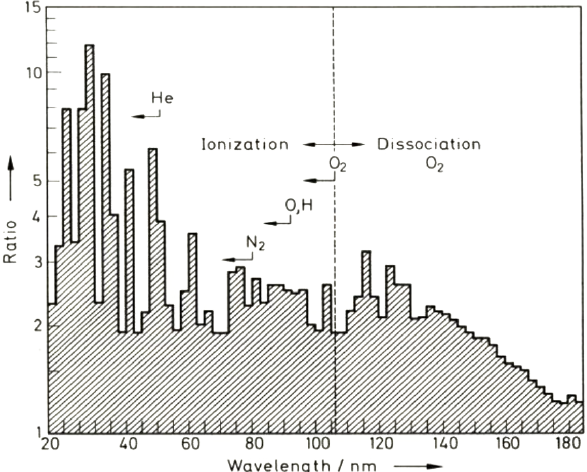
Figure 20. EUVS data from the satellite AE-E (Hinteregger, 1981; copyright permission granted by Elsevier publishing). Ordinates: rate of change from July 1976 (solar activity minimum) to January 1979 (close to